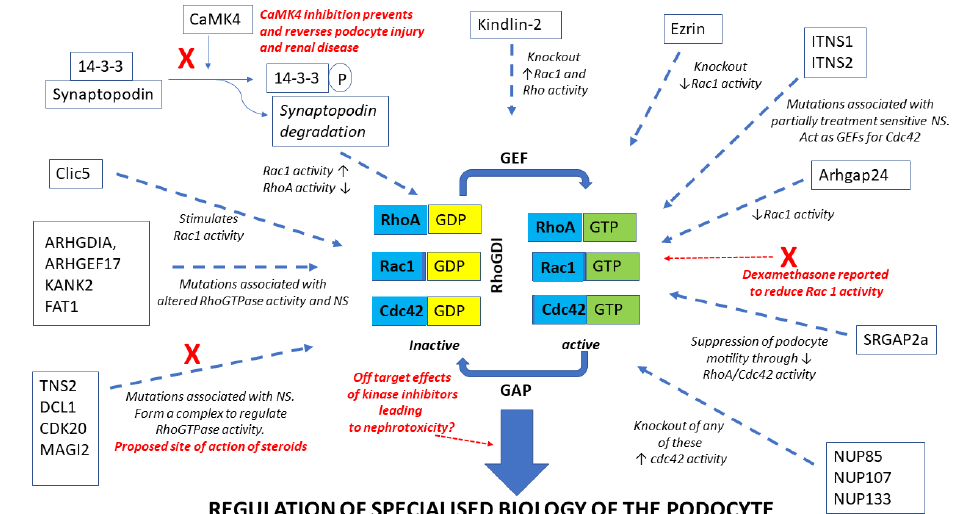
Figure 1. Regulation of the RhoGTPases in the